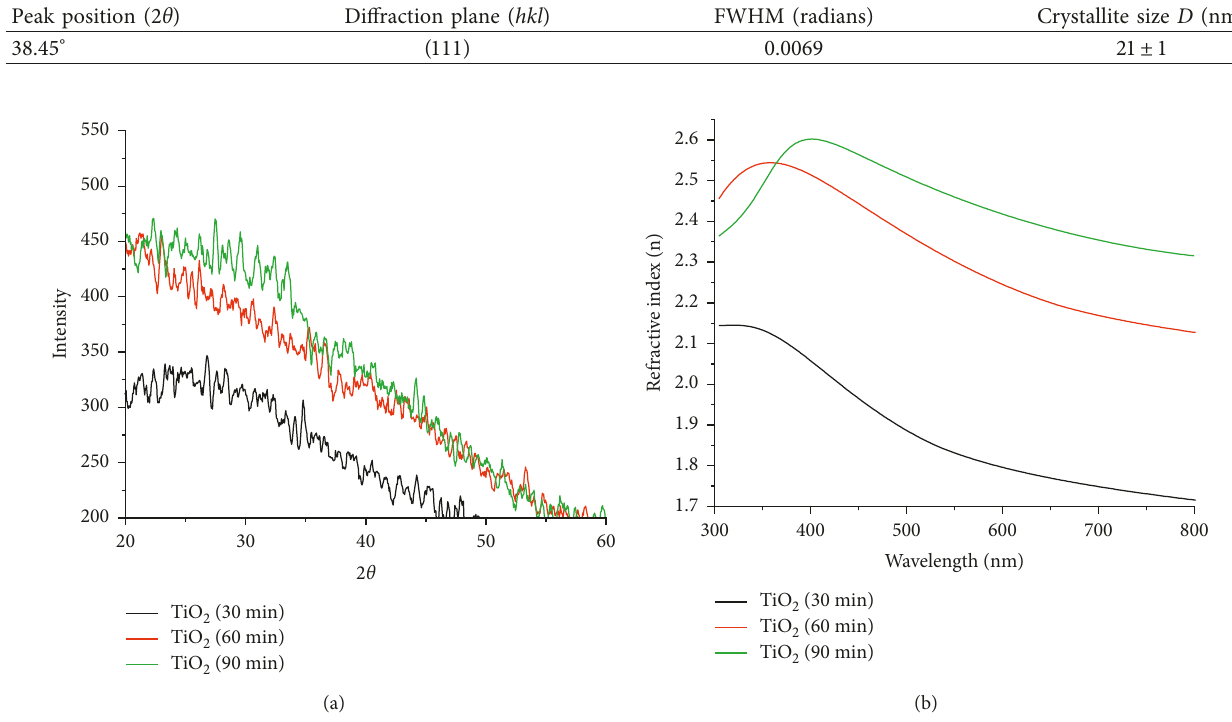
Table 1: Calculated crystallite size of AgNPs.